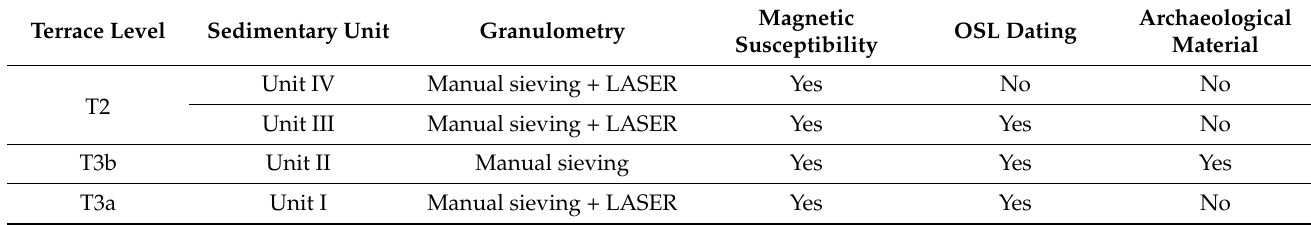
Table 1. Summary of the laboratory works conducted on the different sedimentary units from the studied